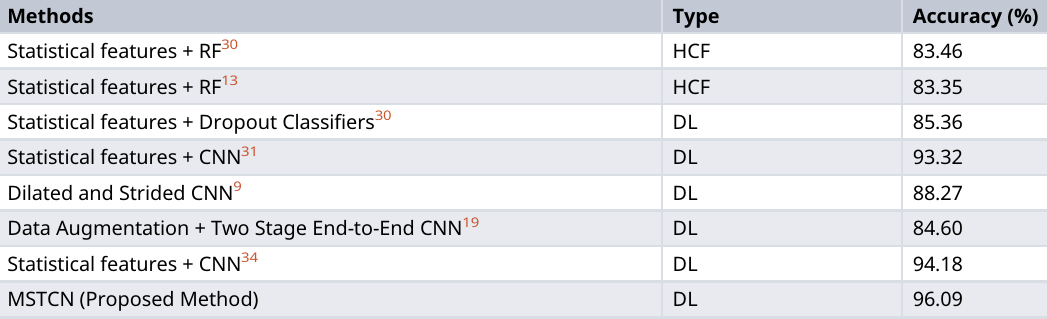
Table 7. Accuracy for user independent WISDM